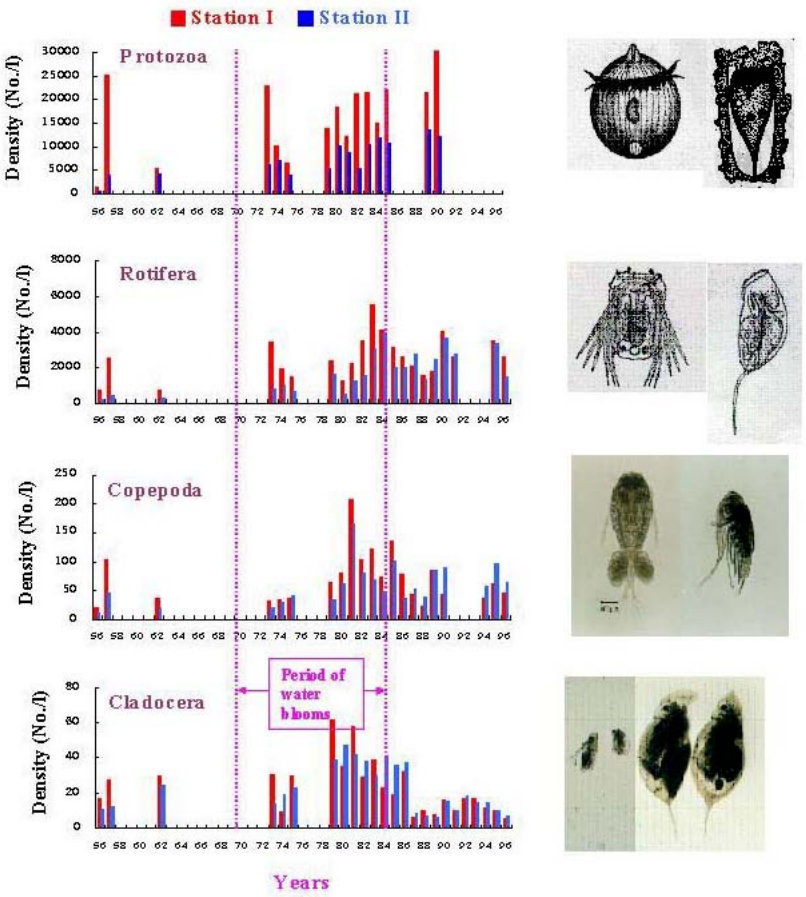
FIGURE 6. Annual mean densities of total Protozoa, Rotifera, Copepoda (including nauplii), and Cladocera at Stations I and II of Lake Donghu (adapted from Xie and Yang[9]).